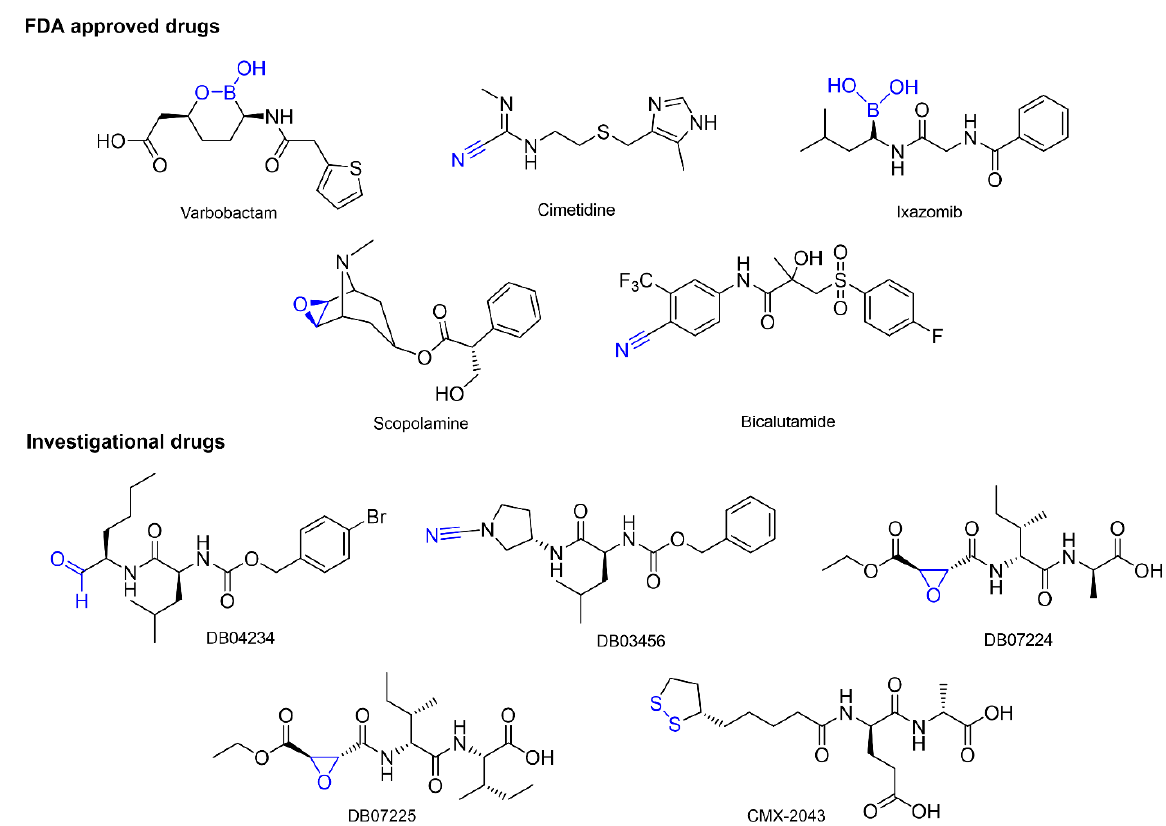
Figure 6. Top five FDA drugs approved and the top five investigational drugs, obtained by a combined structure-based strategy of the pharmacophoric model, virtual screening, and covalent docking. The electrophilic warhead of the promising drugs is shown in blue.